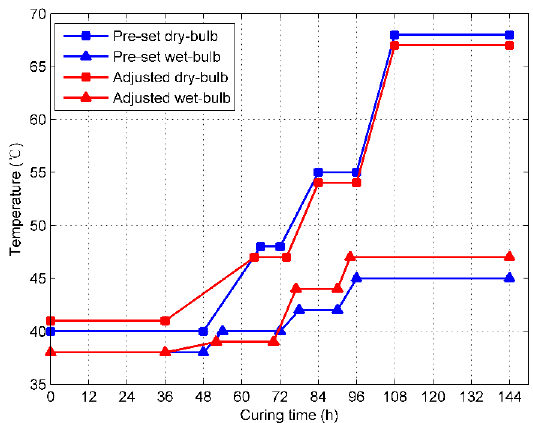
Figure 7. Pre-set and adjusted bulk tobacco curing schedules.